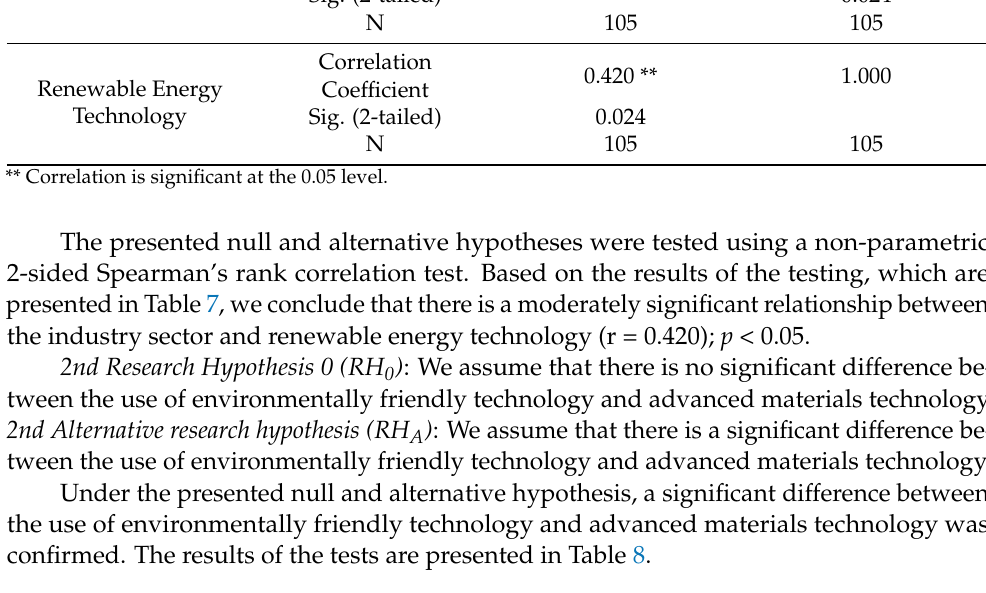
Table 8. Evaluation of null and alternative research hypotheses.